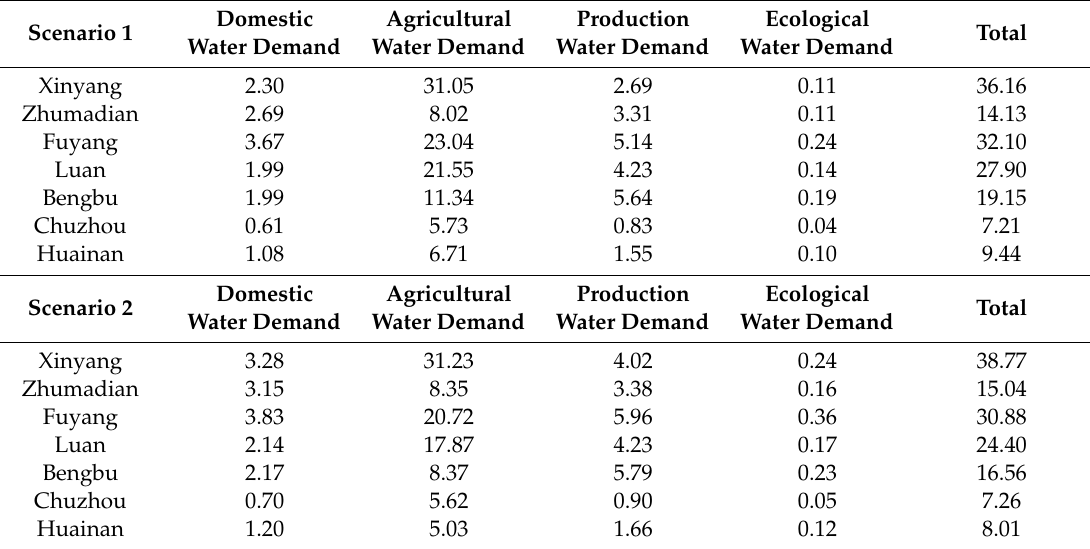
Table 1. Forecast of water demand in 2020 and 2050 (10 8 m 3 ).